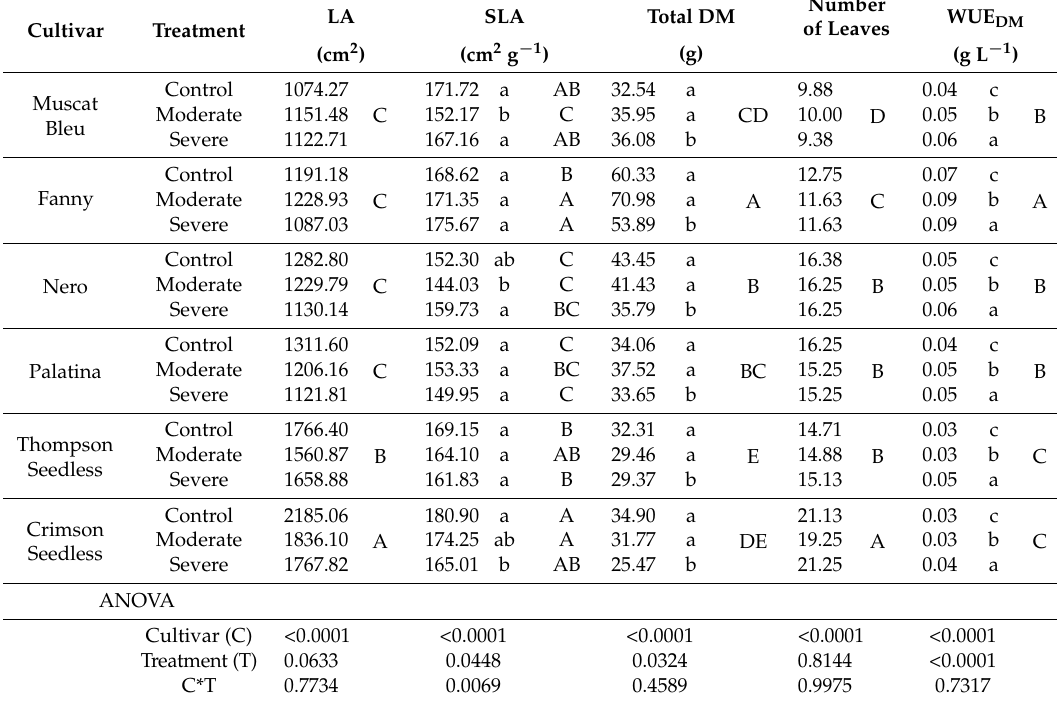
Table 3. Mean values of specific leaf area (SLA) and number of leaves and median values of leaf area (LA), total dry mass (Total DM), and total dry mass water use efficiency (WUE DM ) of six table grape cultivars subjected to three water deficit